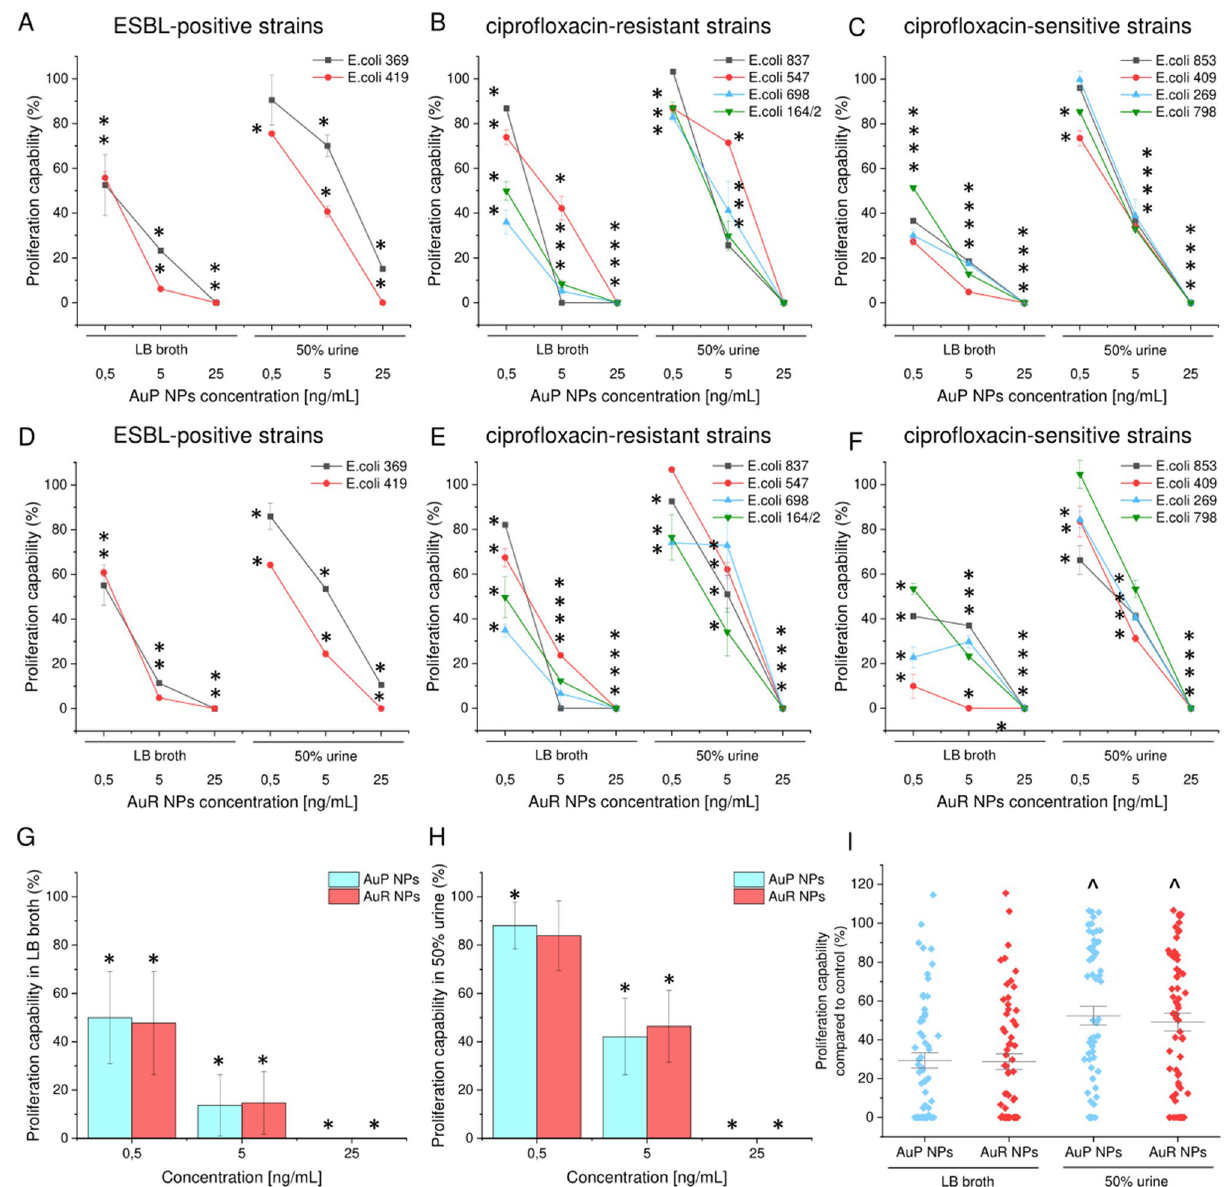
Figure 6. Restriction of Escherichia coli proliferation upon treatment with peanut- (AuP NPs; A – C ) and rod-shaped gold nanoparticles (AuR NPs; D – F ) in the presence of LB broth or LB broth with 50% urine. The proliferation of bacteria upon treatment with gold nanoparticles with concentrations of 0.5, 5, and 25 ng mL −1 was tested using a resazurin-based fluorimetric assay against ESBL-positive strains [( A ) and ( D ); E. coli 369 and 419], ciprofloxacin-resistant strains [( B ) and ( E ); E. coli 837, 547, 698, and 164/2], and ciprofloxacin- sensitive strains [( C ) and ( F ); E. coli 853, 409, 269, and 798]. Panels ( G ) and ( H ) demonstrate the restriction of proliferation of 10 UTI-associated E. coli strains in LB ( G ) and LB containing 50% urine ( H ) as average values. Statistical analysis of the differences in the anti-proliferative abilities of AuP NPs and AuR NPs, in the presence of both growth medium and medium containing 50% urine is presented in panel ( I ). Results are presented as mean ± SD for 3–20 measurements. * and ^ indicates statistical significance ( p < 0.05) when compared to untreated bacteria and samples incubated in LB broth,